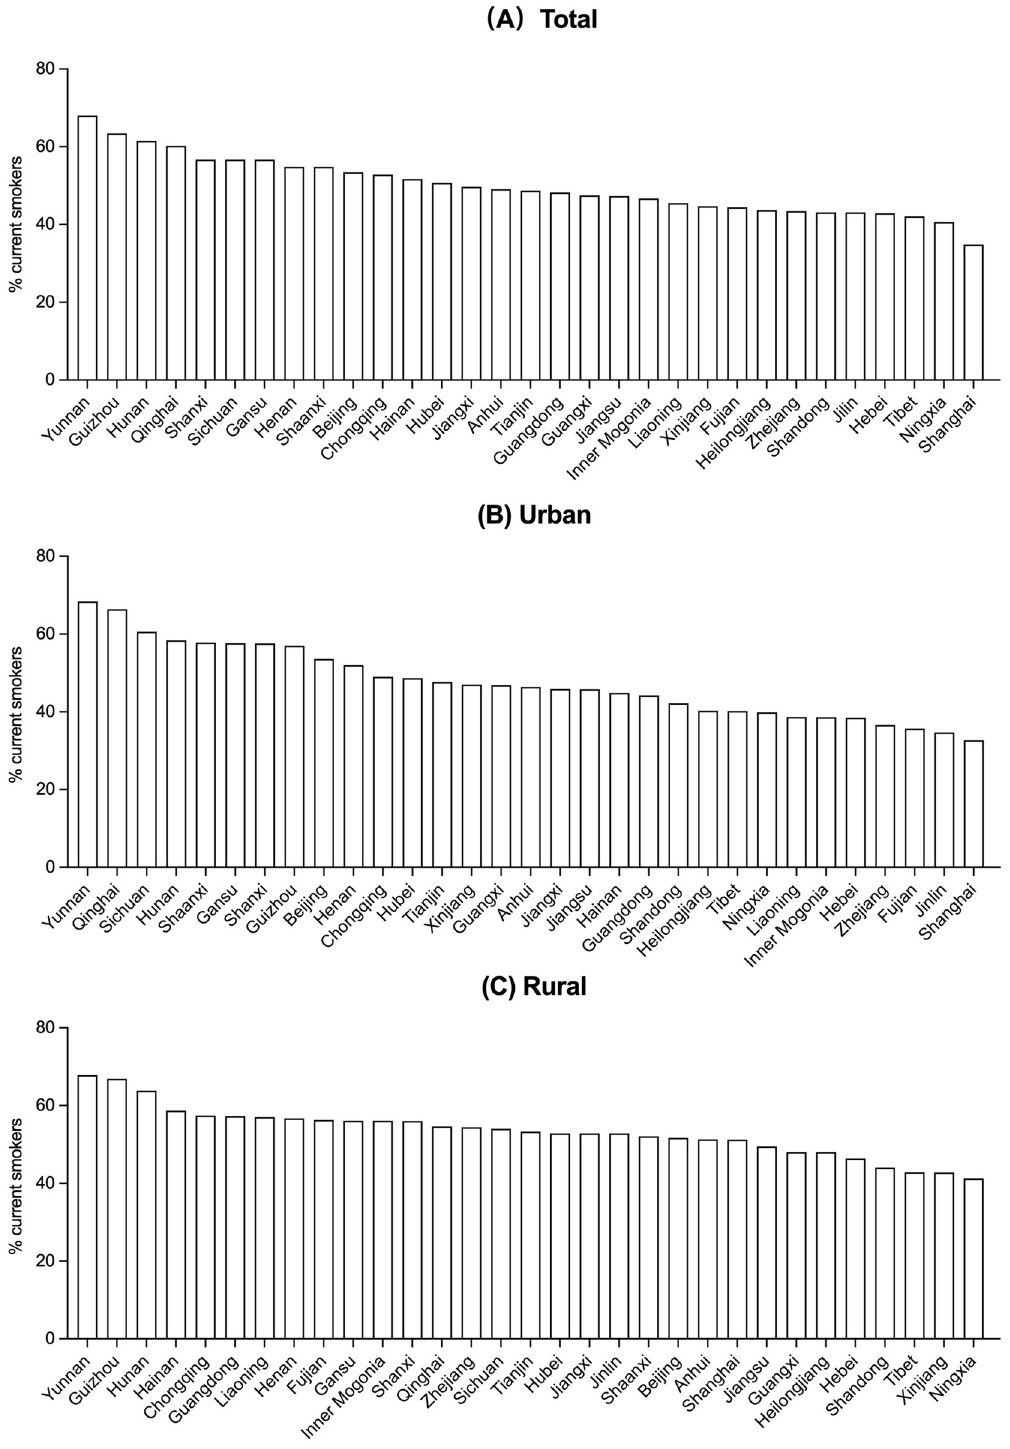
Fig 4. Prevalence of current smoking among men aged � 18 years in 2018, by province for overall (A), urban (B), and rural (C). Data from the 2018 CCDRFS. CCDRFS, China Chronic Disease and Risk Factor Surveillance.